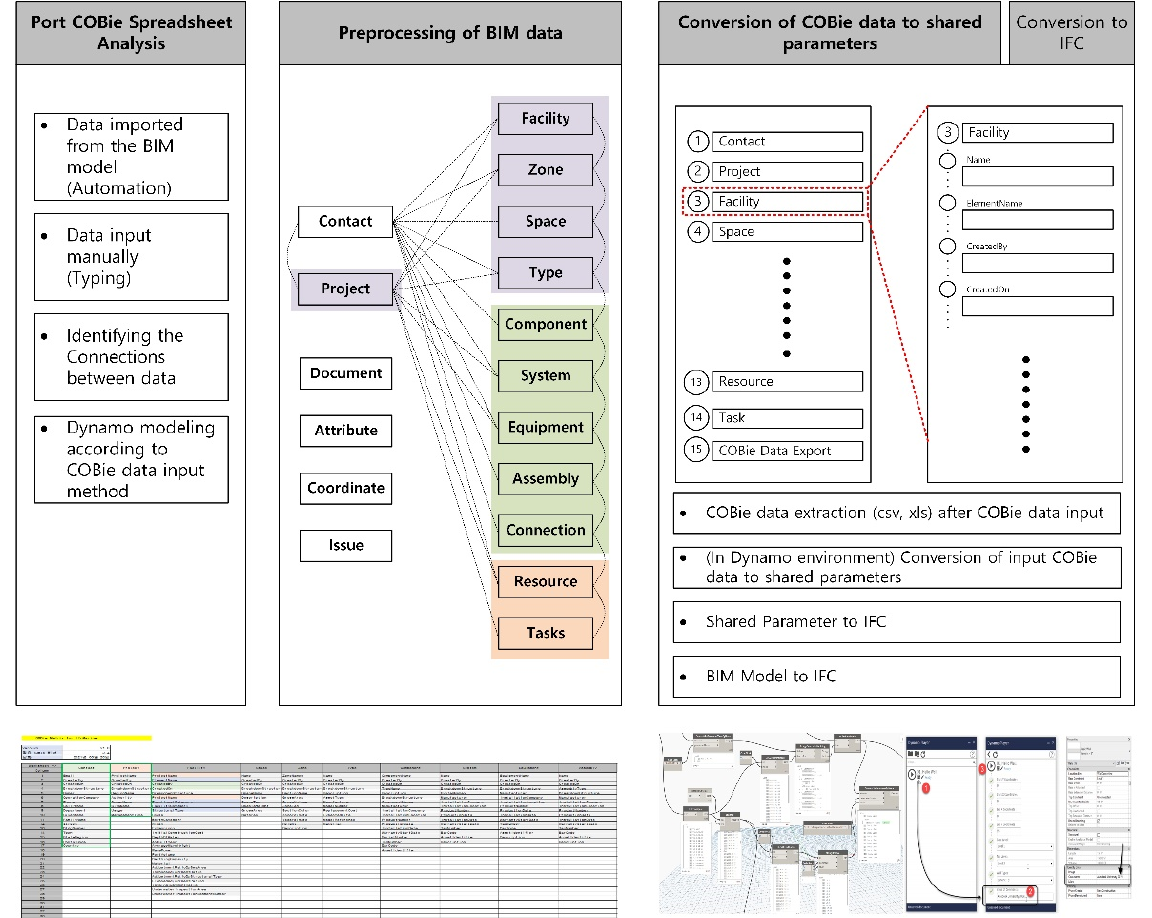
Figure 10. Dynamo-based port COBie data processing system.